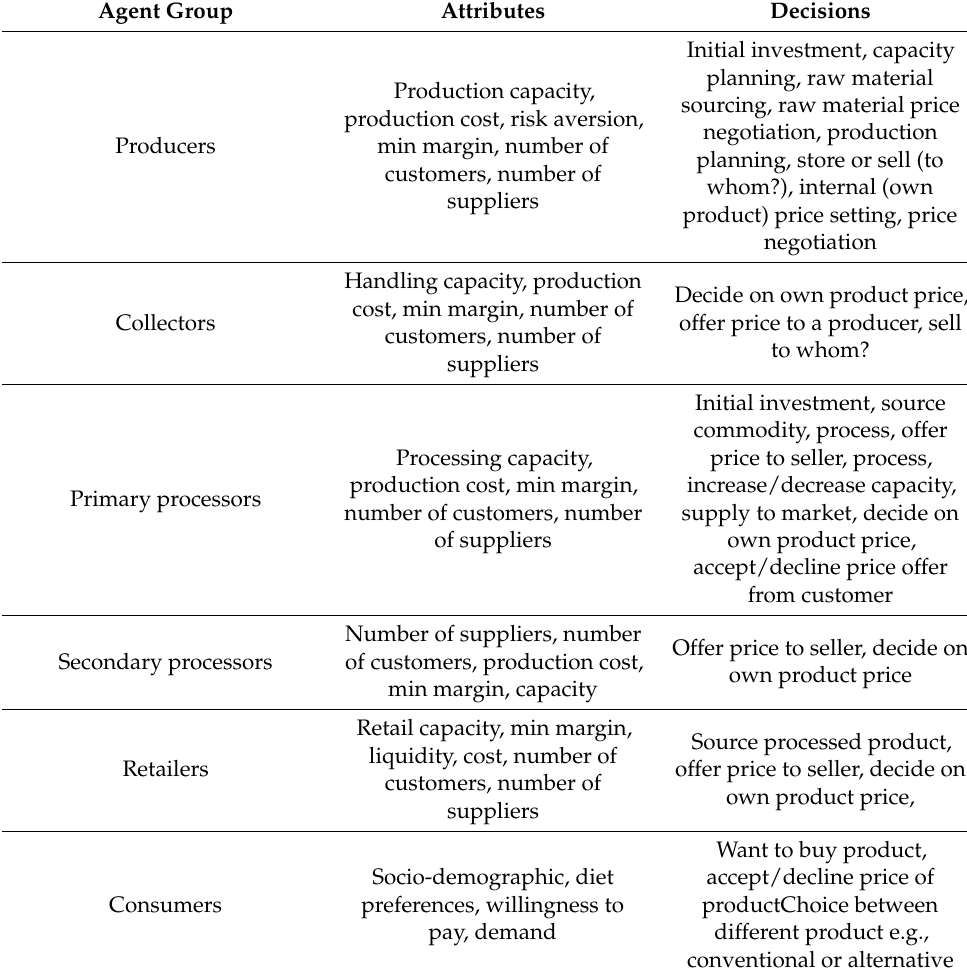
Table 2. Example of agent attributes and decisions for a generic FVC. Agent